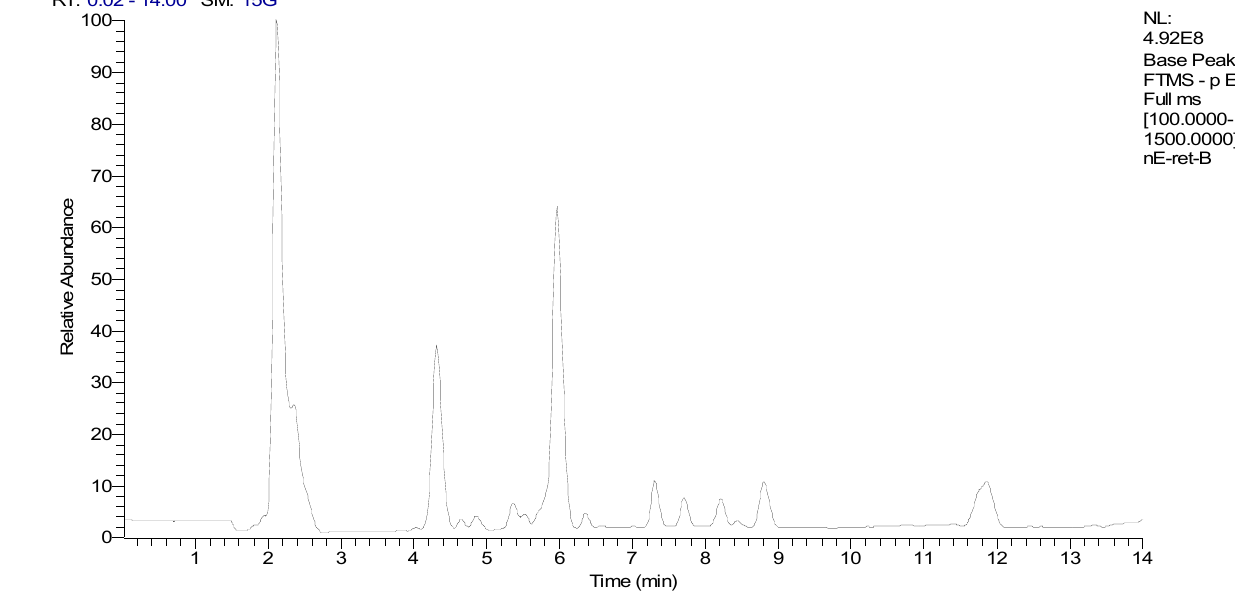
Figure 1. LC-MS profile of aqueous methanolic extract from E. retusa aerial parts. Table 1. Tentative identification of secondary metabolites from E. retusa aerial parts utilizing high- resolution LC-MS/MS.